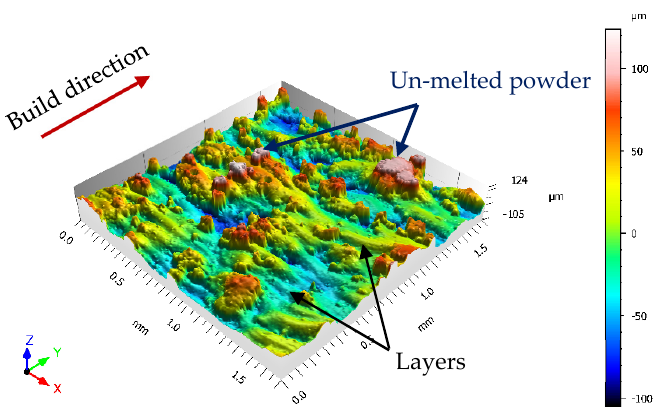
Un-melted powder